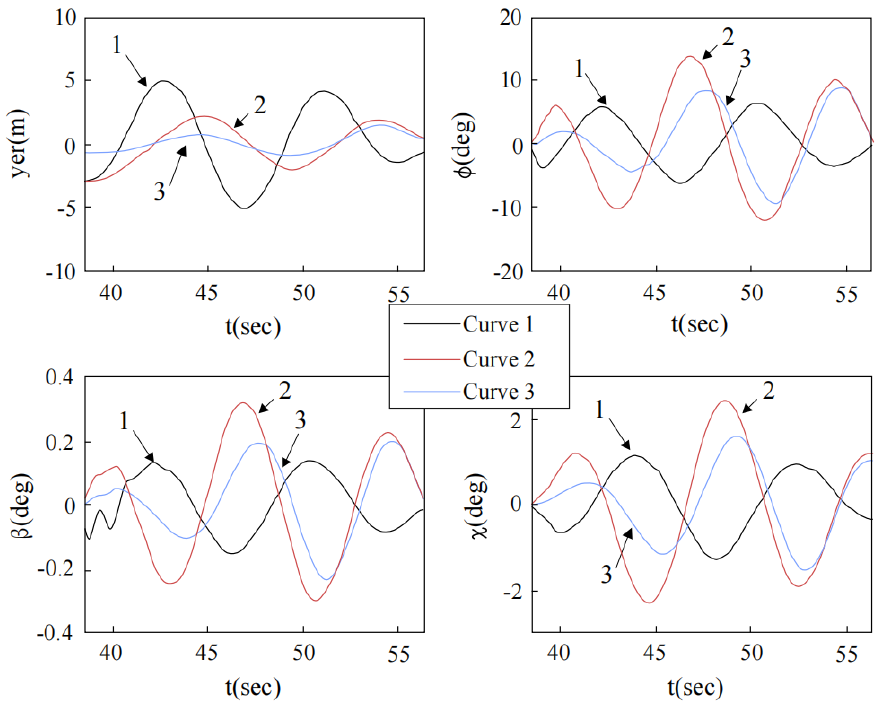
Figure 38. Tracking response curves of measurement axis under inertial tracking strategies with different k values.